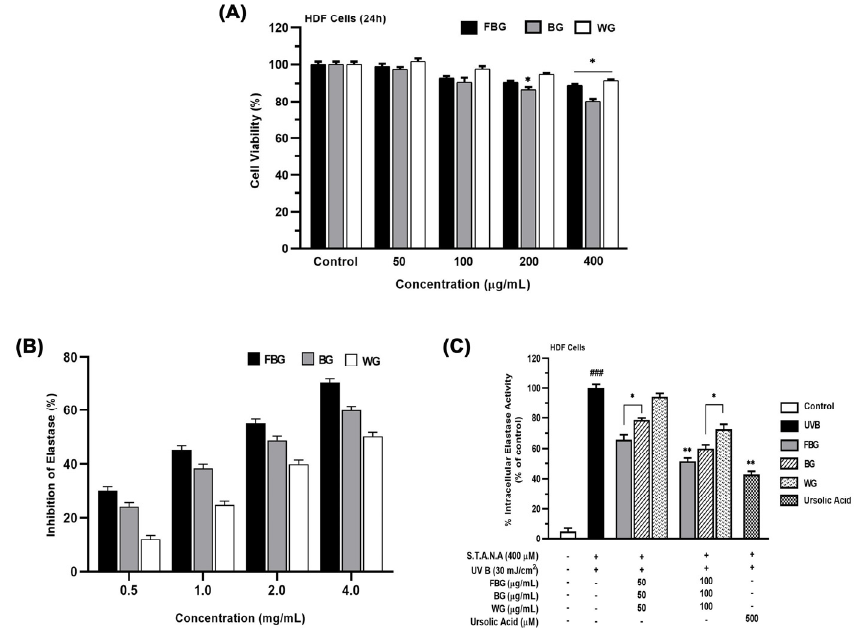
Figure 3. Anti-wrinkle effect of FBG, BG, and WG in HDF cells. ( A ) Cytotoxicity effect of FBG, BG, and WG in HDF cells for 24 h. The cells were treated with each sample at the indicated concentrations (50, 100, 200, and 400 µ g/mL) for 24 h. The cytotoxicity effect was then determined with MTT assays. ( B ) Inhibition of elastase was determined in response to the indicated concentration of FBG, BG, and WG (0.5, 1, 2, and 4 mg/mL). ( C ) Intracellular elastase activity in UVB-irradiated HDF cells was measured in response to the concentration of 100 µ g/mL of FBG, BG, or WG, or ursolic acid (500 µ M). The graph shows mean ± SD values of at least three replicates. ### p < 0.001, as compared with the control group; * p < 0.05, ** p < 0.01, as compared with the UVB-irradiated